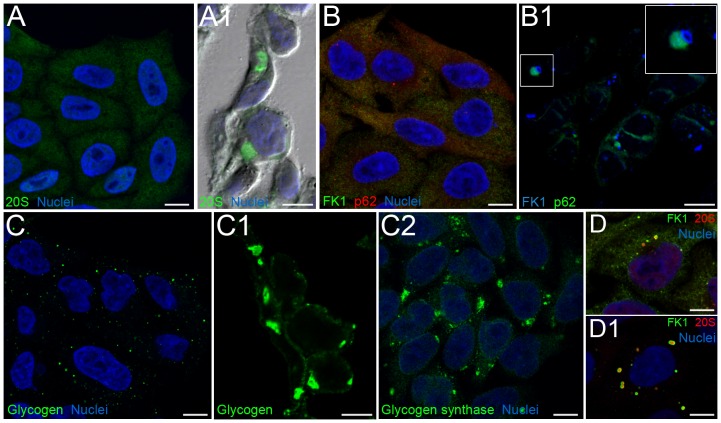
Detection of PaCSs by confocal microscopy.(A) Only weak diffuse 20S proteasome immunofluorescence was seen in control HeLa cells after standard preparation (i.e., 15 min paraformaldehyde fixation), compared to the large 20S proteasome-reactive structures visible after aldehyde–osmium fixation and paraffin-embedding (A1, immunofluorescence and phase-contrast overlay). (B) Poor FK1 reactivity (green) and a few p62-reactive (red) spots were seen in the cytoplasm of standard-prepared HeLa cells, whereas after aldehyde–osmium fixation, large FK1-positive (blue) structures appeared (B1), lacking colocalization with p62 green fluorescence despite occasional juxtaposition (inset). (C) Only scattered minute glycogen deposits appeared in standard-prepared cells, whereas large deposits were seen after aldehyde–osmium fixation (C1); large deposits of glycogen synthase were seen after methanol fixation (C2). Standard confocal microscopy of epoxomicin-treated (D) or puromycin-treated (D1) HeLa cells showed prominent FK1/20S proteasome-reactive cytoplasmic bodies. Bars, 10 µm.